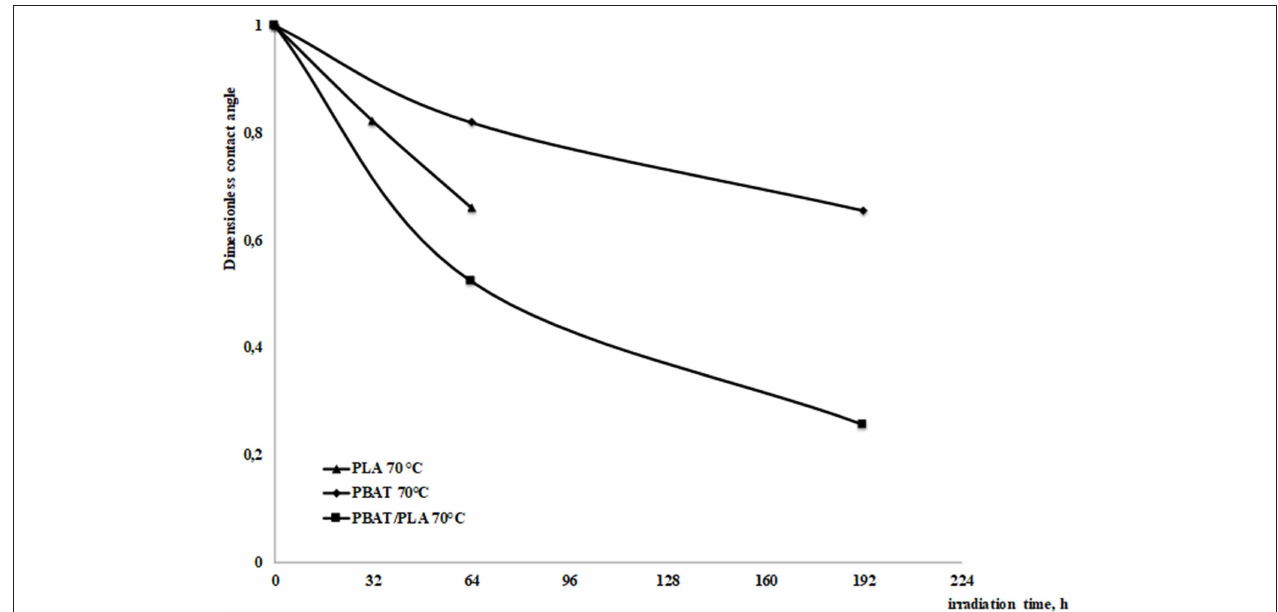
FIGURE 13 | Dimensionless contact angles measured for the investigated